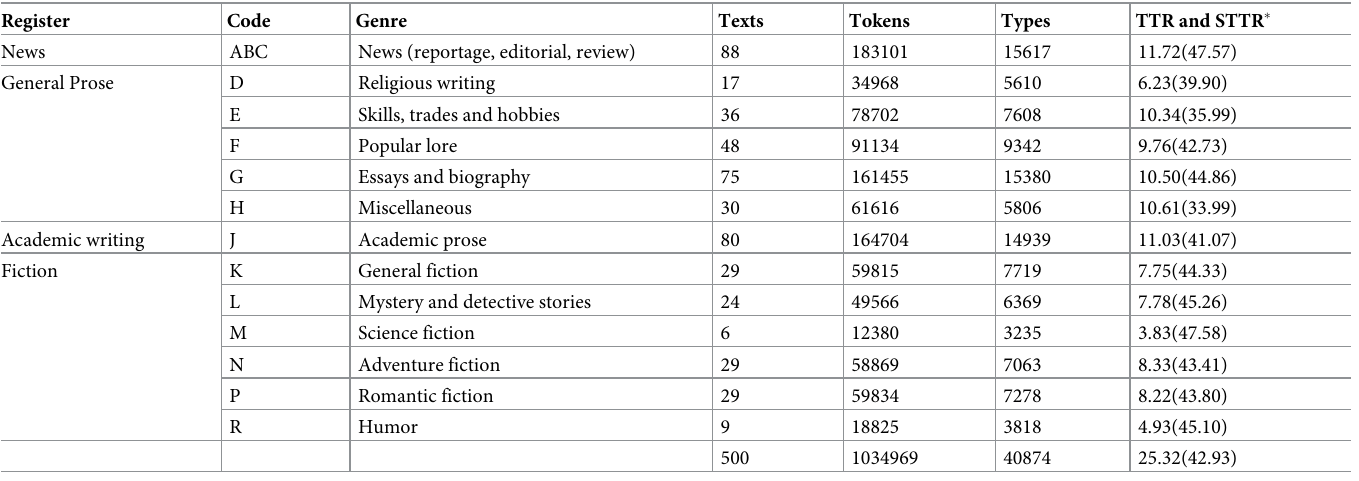
Table 1. Design scheme of COCE and statistical facts of its English